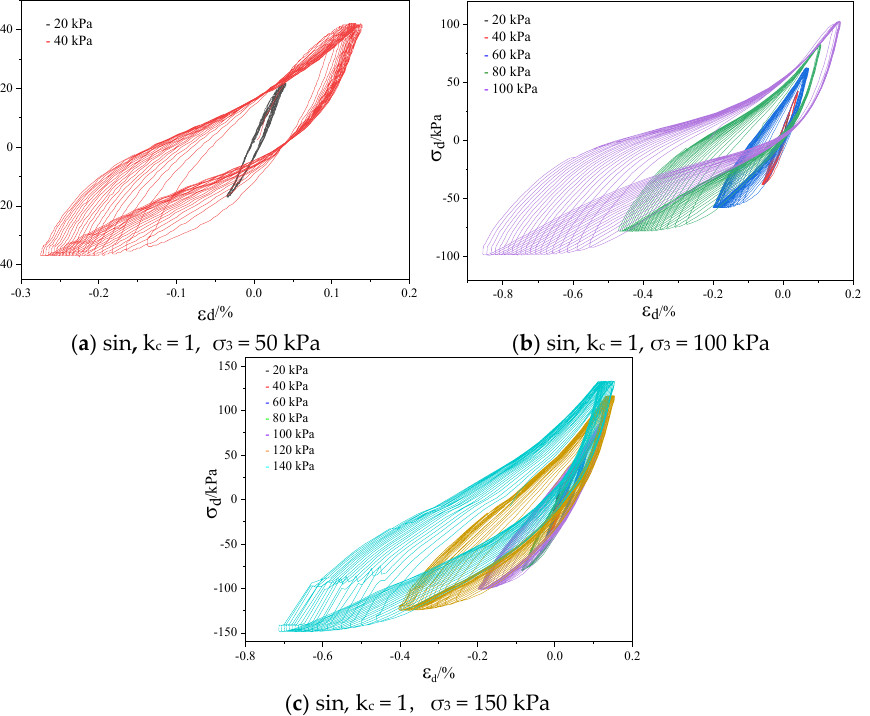
Figure 6. Analysis of hysteretic curve characteristics under different confining pressures.